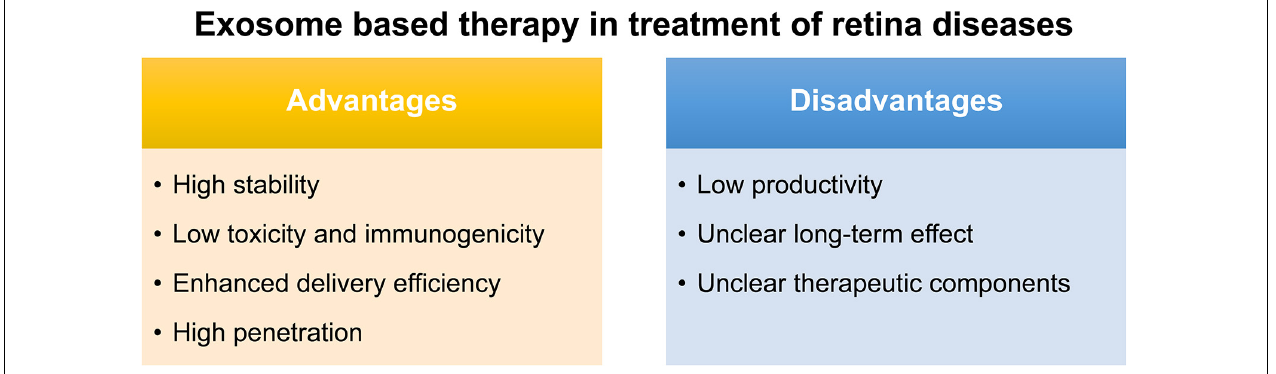
FIGURE 2 | Advantages and disadvantages of exosome-based therapy in treatment of retinal diseases.